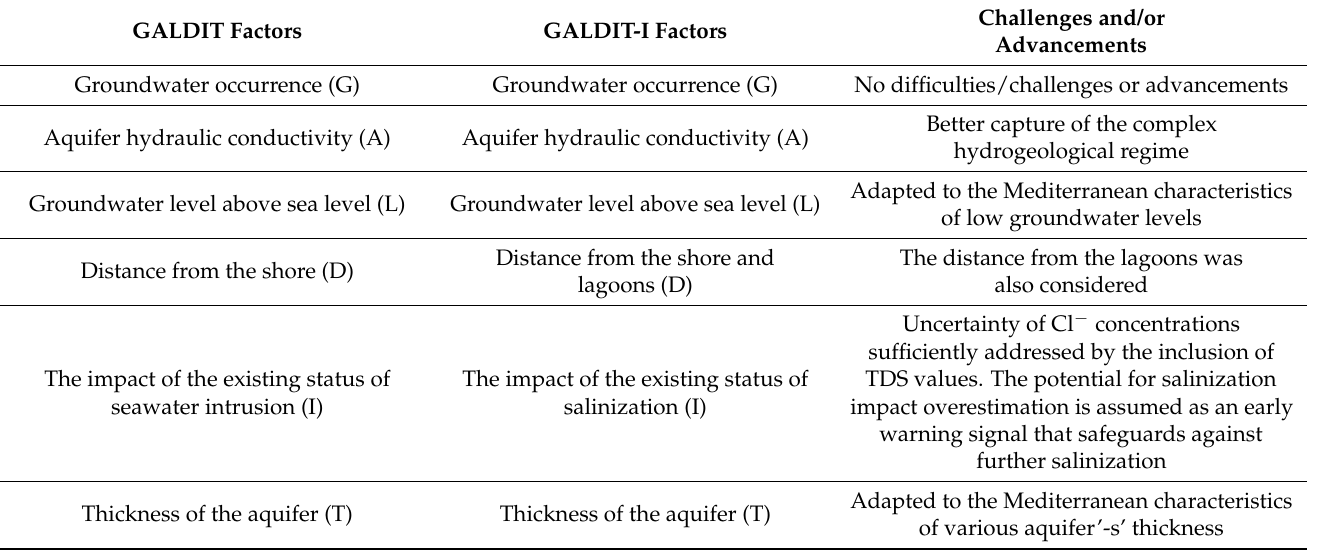
Table 11. Challenges phased and/or advancements achieved by the GALDIT-I